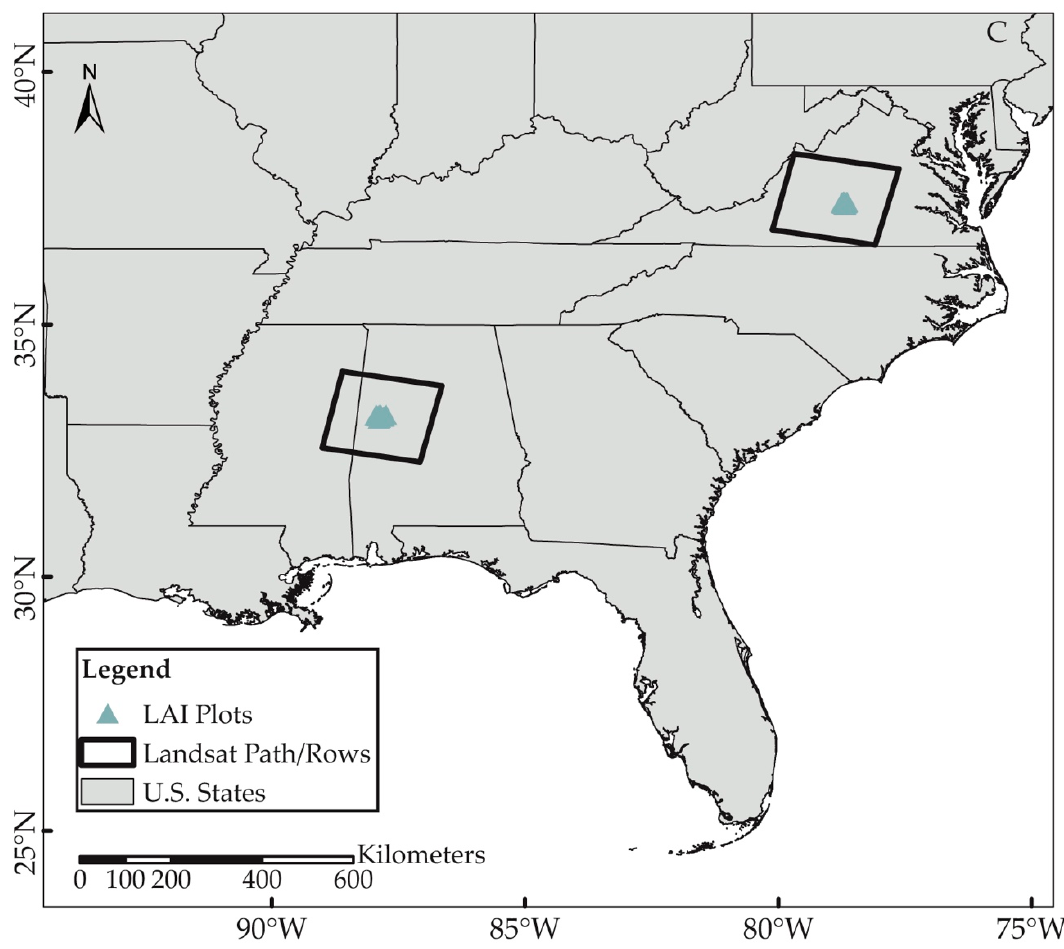
Figure 1. Ground LAI plot locations shown as yellow triangles over Landsat 8 OLI imagery displayed with the color-infrared band combination NIR, Red, Green as RGB. The Virginia site is on the top left ( A ) over a 16/34 OLI image from 14 March 2014 and the Alabama site is on the top right ( B ) over a 21/37 OLI image from 13 February 2014. ( C ) shows the study site locations within Virginia and Alabama, U.S. and Landsat path/rows used.